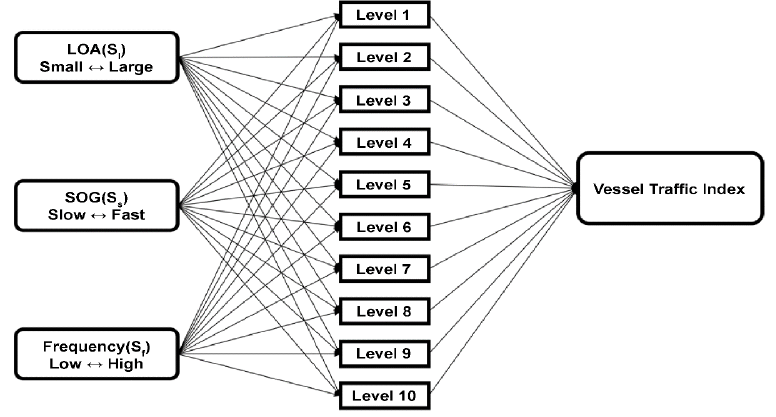
Figure 11. Level settings for major review items of the vessel traffic index.